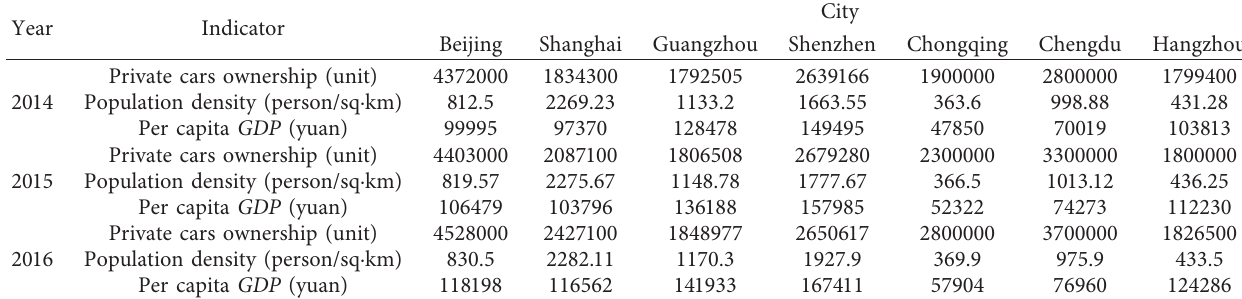
Table 1: Related indicators of the experimental